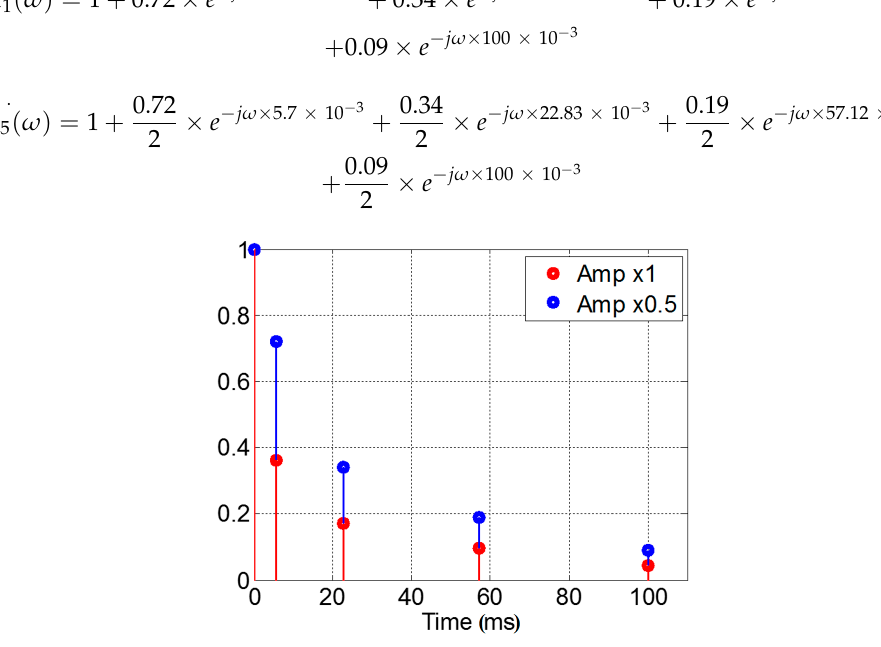
Figure 4. Test channel responses of the underwater acoustic channel.